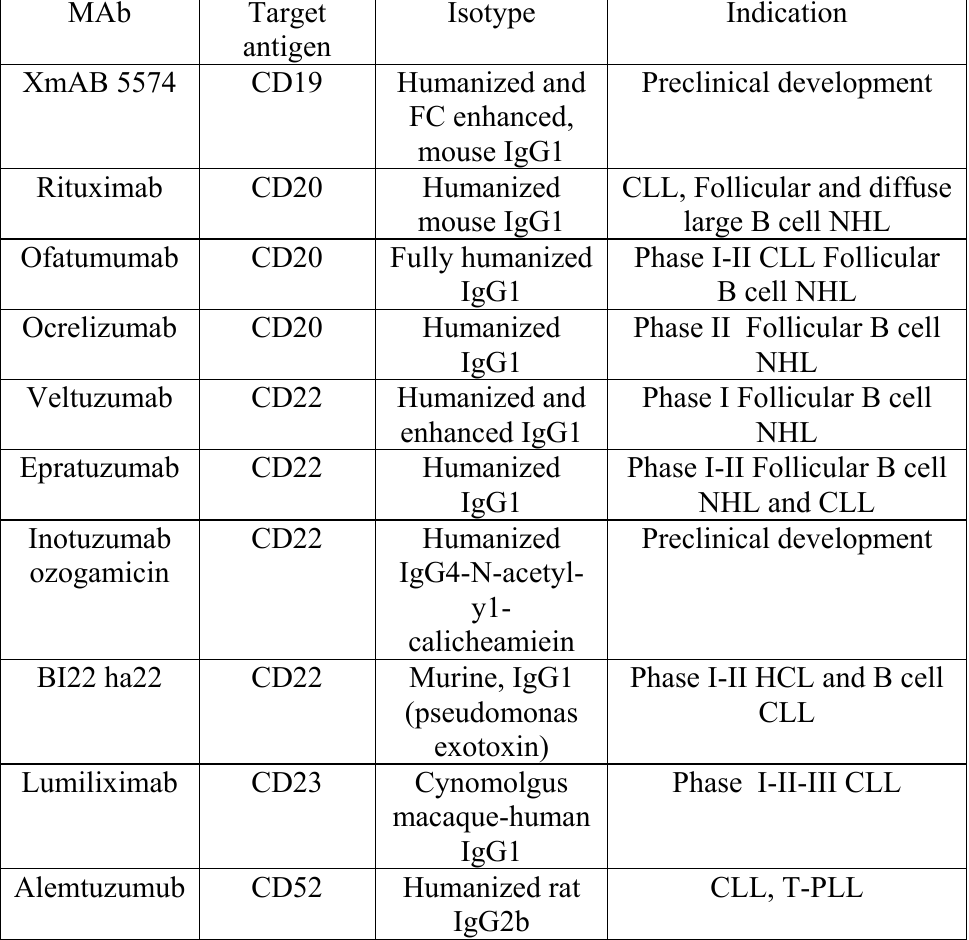
Table 1. Monclonal ABs in lymphoproliferative